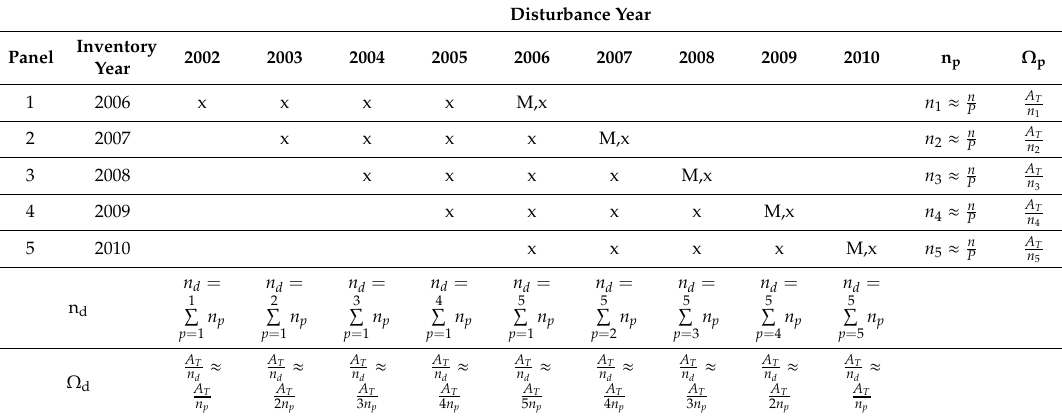
Table 2. Schematic depicting the Forest Inventory and Analysis (FIA) panel design where “M” identifies the year each panel ( p ) is measured and “x” identifies the corresponding years where disturbance can be retrospectively recorded by a field measurement. The total number of plots ( n ) from panels p = 1 to 5 are decomposed by panel ( n p ) and disturbance year ( n d ). The overall sampling weight Ω = A T / n is also decomposed into panel sampling weight ( Ω p ) and disturbance year sampling weights ( Ω d